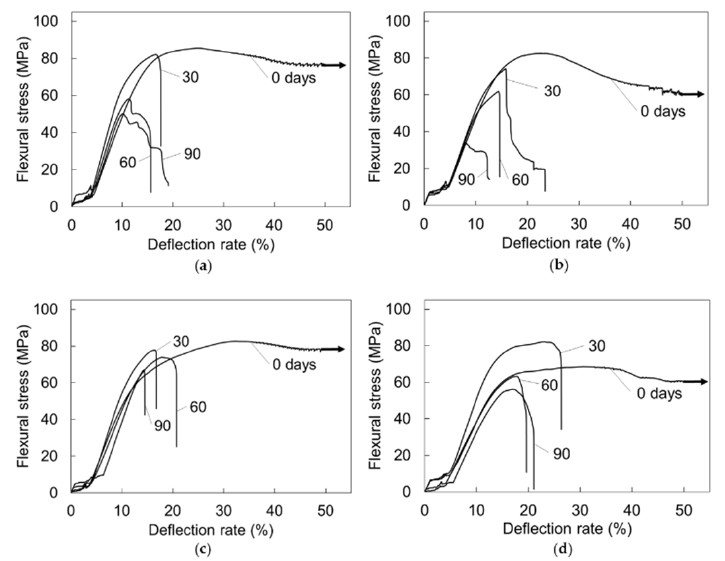
Figure 7. Representative changes of the stress–deflection rate curves of the flexural test pieces after immersion for certain periods. ( a ) P. 100% , ( b ) P. 80% , ( c ) C. 100% , and ( d ) C. 80% . The arrow indicates that the test piece has not reached breakage.